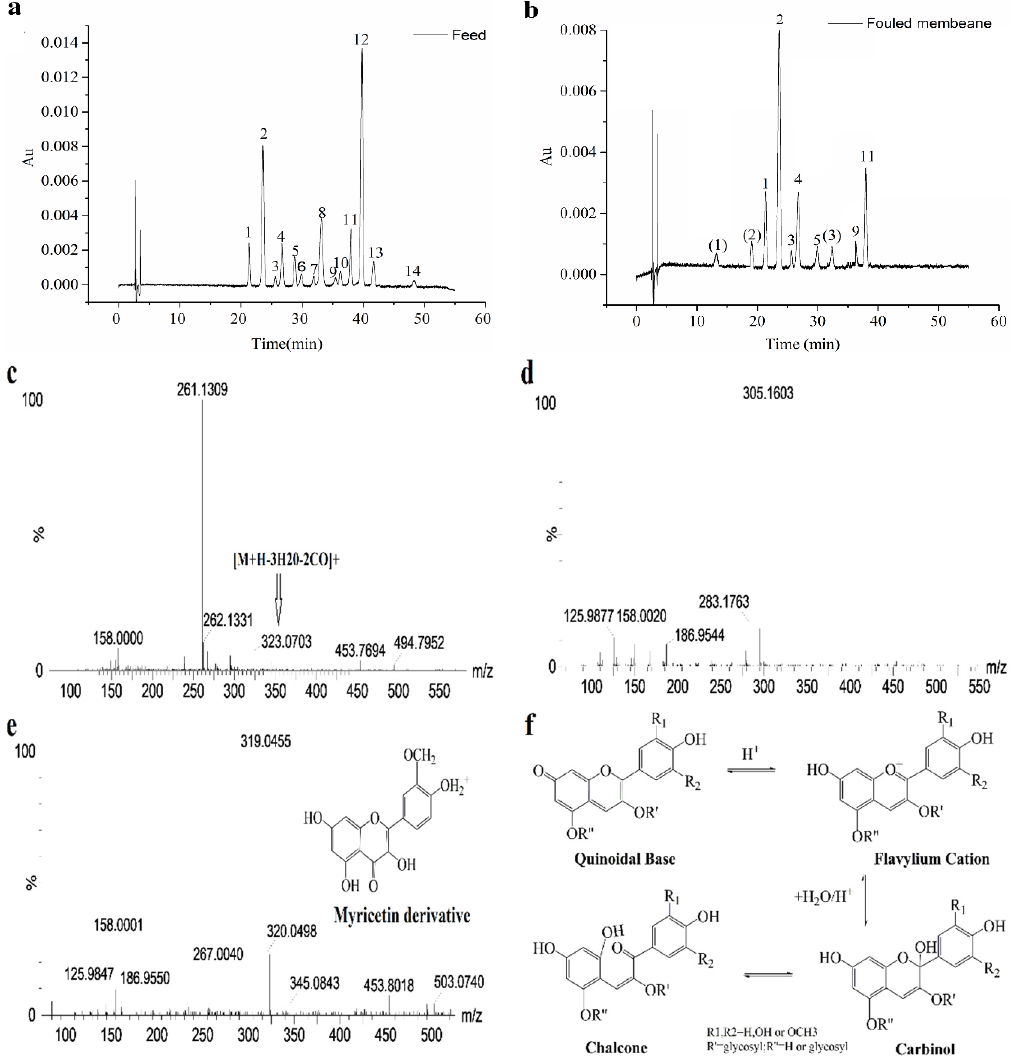
Figure 4. HPLC chromatogram profiles of anthocyanins in extracts and foulants. ( a ) anthocyanins of feed; ( b ) anthocyanins in membrane foulants (peaks’ assignments are shown in Table 2); ( c ) MS spectra of peak (1); ( d ) MS spectra of peak (2); ( e ) MS spectra of peak (3); ( f ) Equilibrium between the four forms of anthocyanins [29].